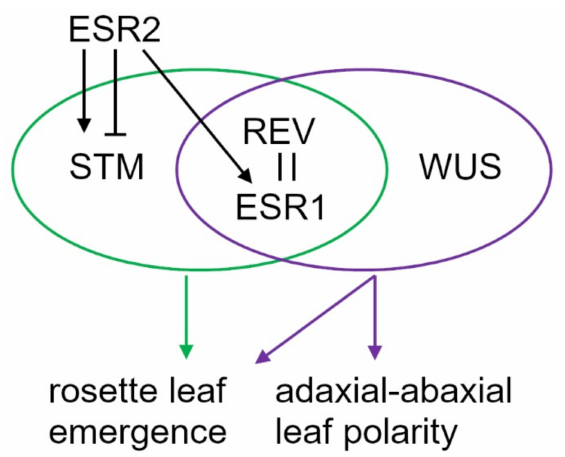
Figure 5. Schematic representation of genetic interactions. The REV and ESR1 protein interaction is confirmed. Together with STM or WUS, both ESR1 and REV participate in the rosette leaf emergence and the establishment of adaxial–abaxial polarity. ESR2 and ESR1 are functionally interchangeable whereas the effect of ESR2 on rosette leaf emergence in the stm/bum mutant is vegetative phase-